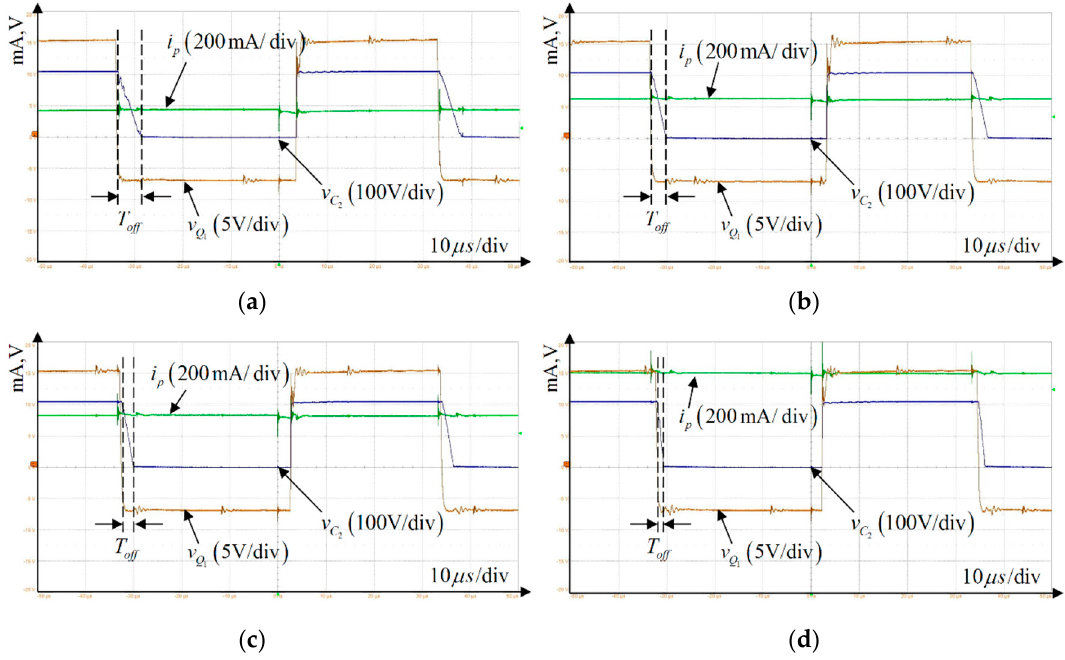
v ; ( b ) lower output capacitor voltage 1 Q